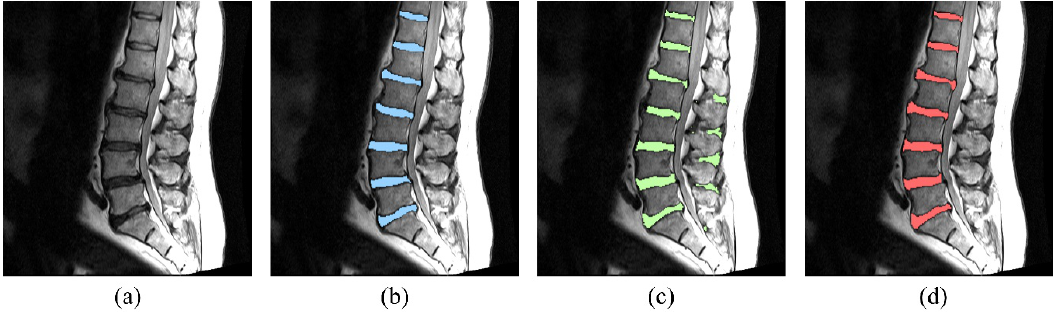
Figure 7. Segmentation results of the networks overlaid on the input image. ( a ) The input magnetic resonance (MR) image. ( b ) The input MR image with U-net segmentation result. ( c ) The input MR image with the result from the modified U-net which is U-net whose convolutional and pooling layers are replaced with BSU-layers. ( d ) The input MR image with BSU-net result.